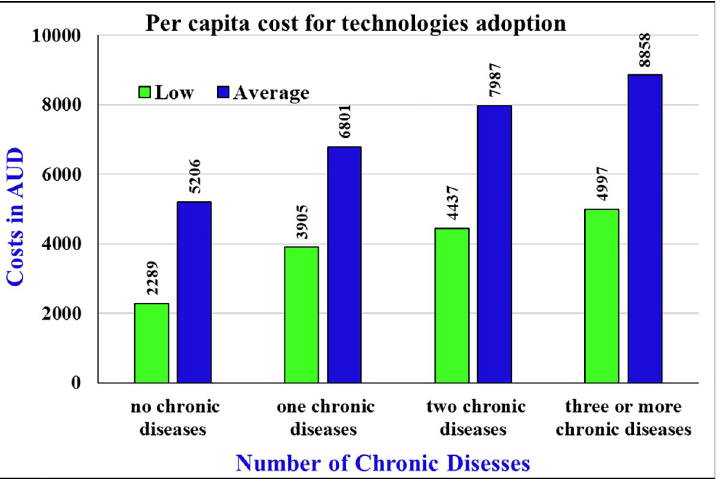
Fig 4. Per capita cost for technologies adoption for the different